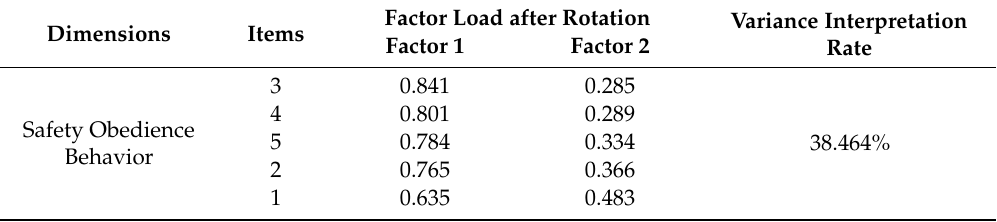
Table 3. Factor load matrix after rotation: the COVID-19 safety behavior